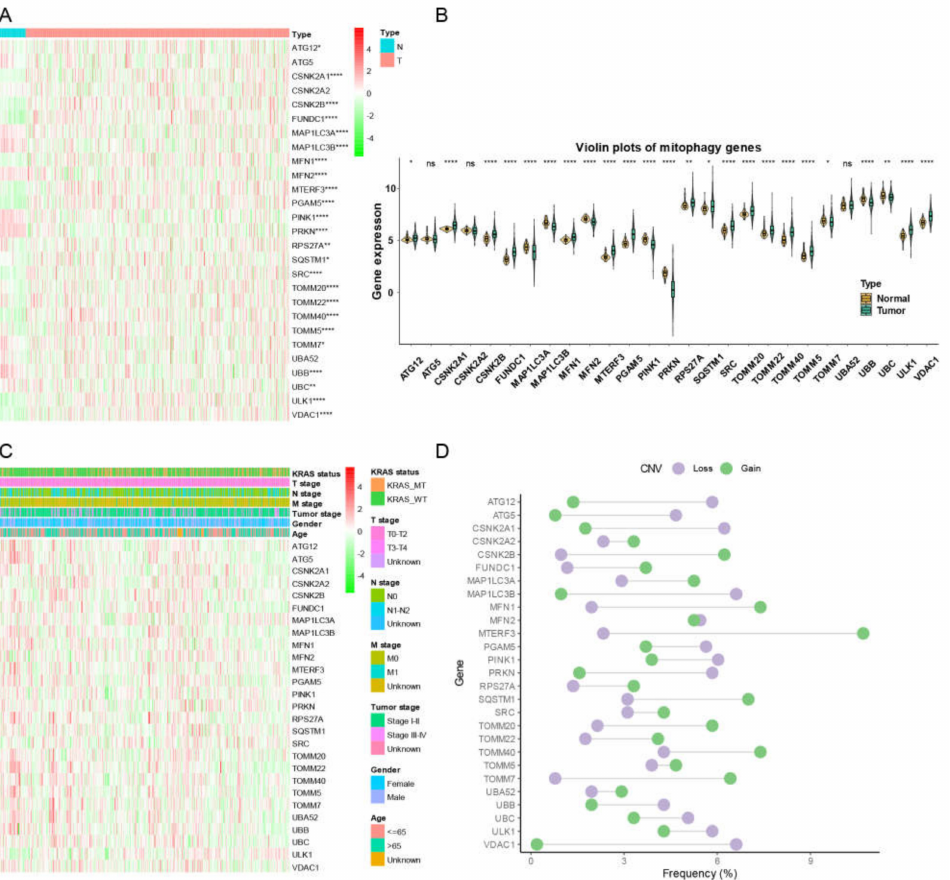
Figure 1. The landscape of gene expression and CNV of mitophagy genes in LUAD. ( A ) the heatmap of the gene expression level of mitophagy genes between normal (N) and tumor (T) tissues of LUAD in TCGA. ( B ) the violin plots which presented the expression of each mitophagy gene between normal and cancer tissues of LUAD in TCGA. ( C ) the expression of mitophagy genes in LUAD with clinicopathological features that comprises age, gender, T stage, M stage, N stage, tumor stage, and KRAS status. ( D ) the CNV distribution of mitophagy genes in TCGA database. The asterisks represented the statistical p value (* p < 0.05; ** p < 0.01; **** p < 0.0001, “ns” represents p value over